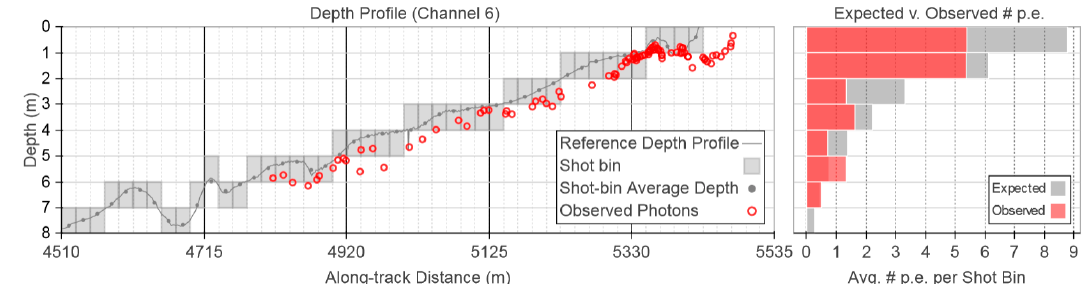
Figure 11. Left: A portion of the depth profile from channel 6 illustrates the comparison between the observed photon returns and the reference Laser Airborne Depth Sounder (LADS) MkII dataset. The expected numbers of photoelectrons (p.e.) for each shot bin was calculated based on the average depth of the shot bin. Right: The corresponding (channel 6) average expected and observed numbers of photoelectrons for each depth range were calculated by averaging the respective values from the populated shot bins in that depth range.